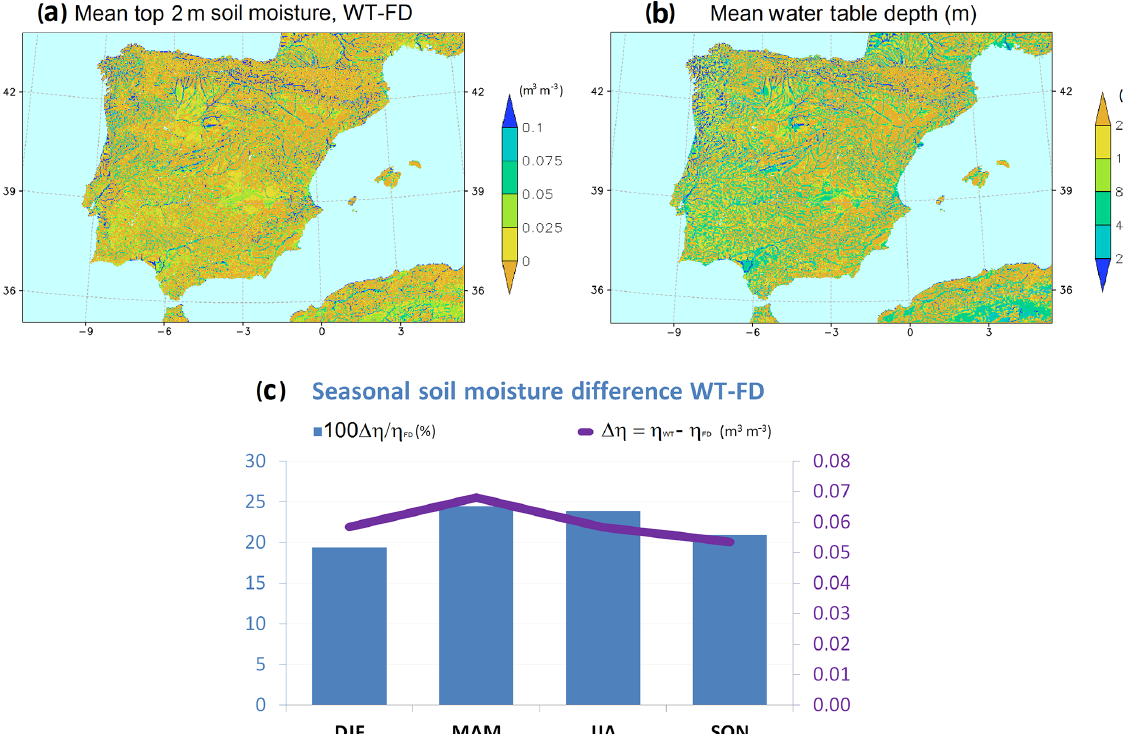
Figure 8. (a) Mean top 2m soil moisture difference (WT − FD; volumetric water content, m 3 m − 3 ). (b) Mean wtd (m). (c) Seasonal top 2m soil moisture differences between the experiments with and without groundwater (WT − FD), averaged over the Iberian Peninsula shallow water table regions (wtd ≤ 8m): percent of soil moisture increase (%; blue columns) and soil moisture absolute difference (volumetric water content, m 3 m − 3 ; purple line).